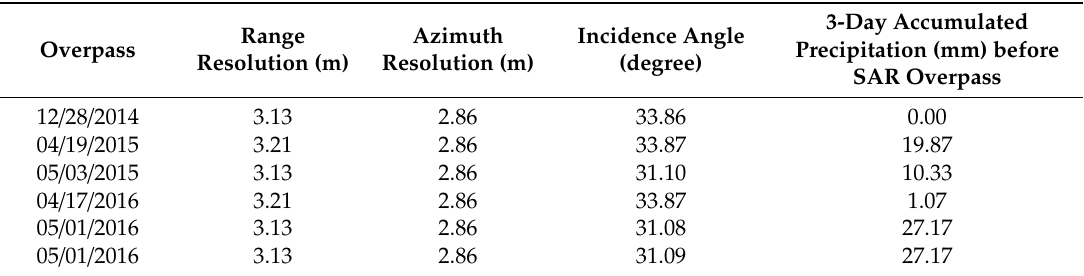
Table 2. Main characteristics of the ascending, full polarimetric ALOS / PALSAR-2 StripMap (SM2) acquisition mode images selected for this